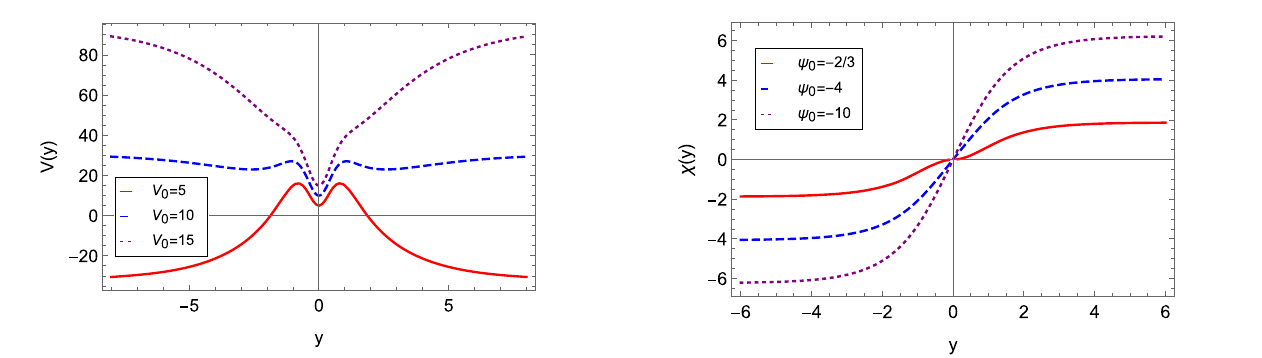
Fig. 5 Solutions for the matter field χ ( y ) from Sect. 3.4 with ϕ 0 = 1, A 0 = 1 and k = 1. The solutions cross the origin y = 0 and approach asymptotically constant values for | y | (cid:7)